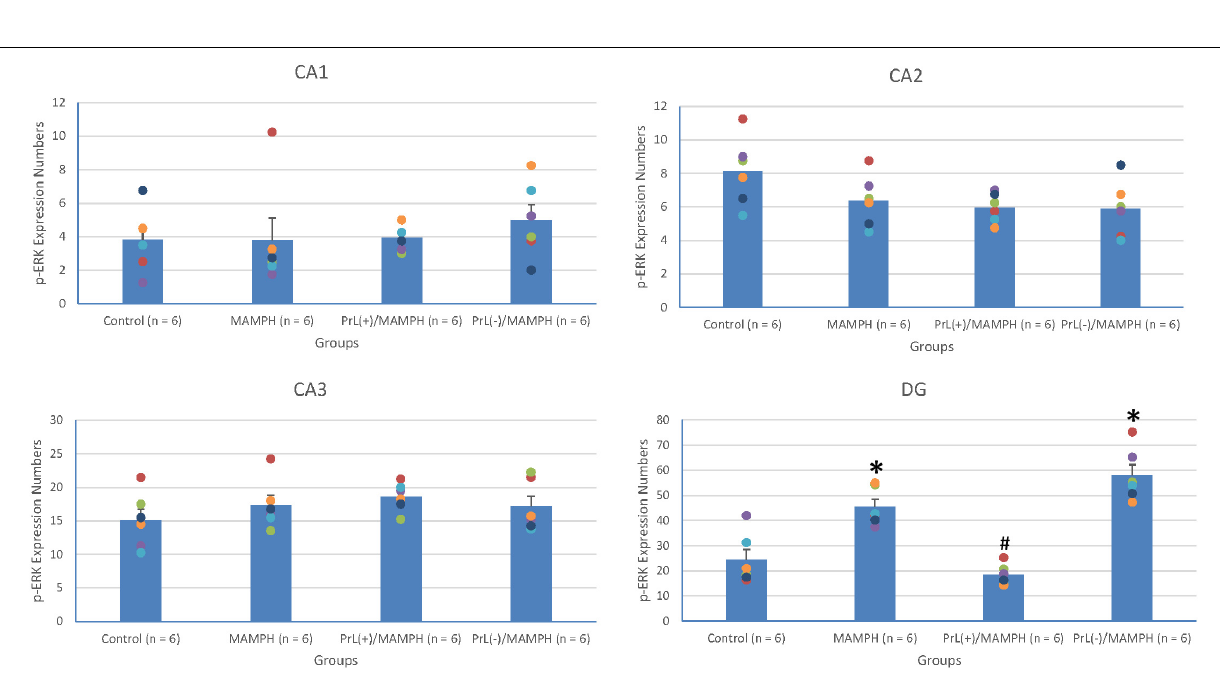
Frontiers in Aging Neuroscience |